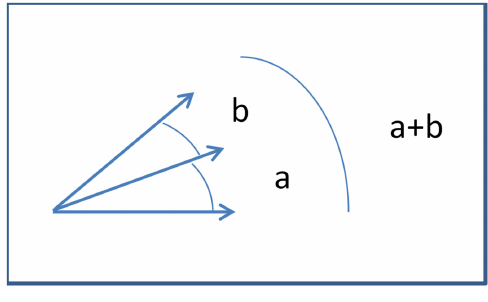
Figure 12. Transitivity of the